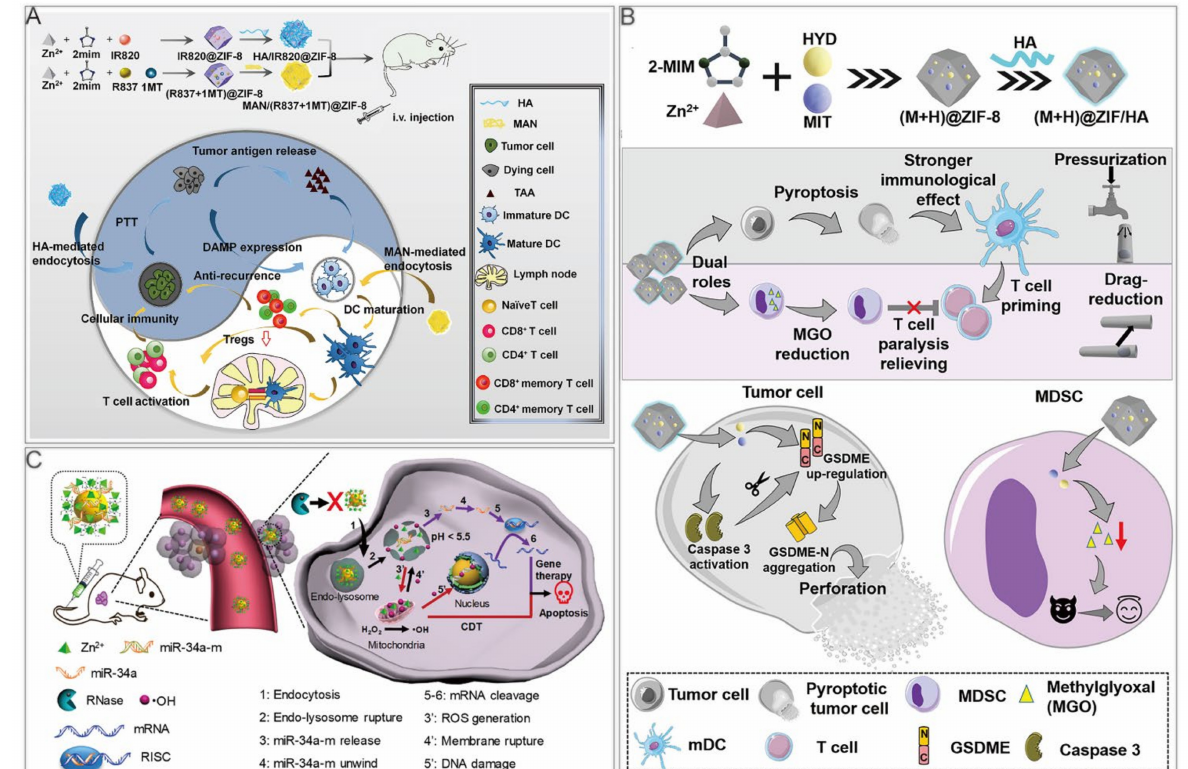
Figure 6. ZIF–8 nanoplatforms for dual cancer therapy. ( A ) ZIF–8 nanoplatforms for immunother- apy/PTT. Reprinted with permission from Ref [100]. Copyright 2020 Elsevier Ltd. ( B ) ZIF–8 nanoplat- forms for immunotherapy/chemotherapy. Reprinted with permission from Ref [105]. Copyright 2021 American Chemical Society. ( C ) ZIF–8 nanoplatforms for GT/CDT. Reprinted with permission from Ref [93]. Copyright 2021 American Chemical